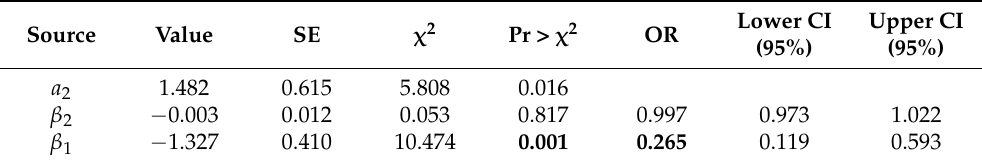
Table 8. The parameters of the logistic model characterizing the relationship between the variable Y 2 : “Have you taken any COVID-19 treatment?” and the variables X 2 and Z 2 (Model 4). Bold values indicate a statistically significant impact.